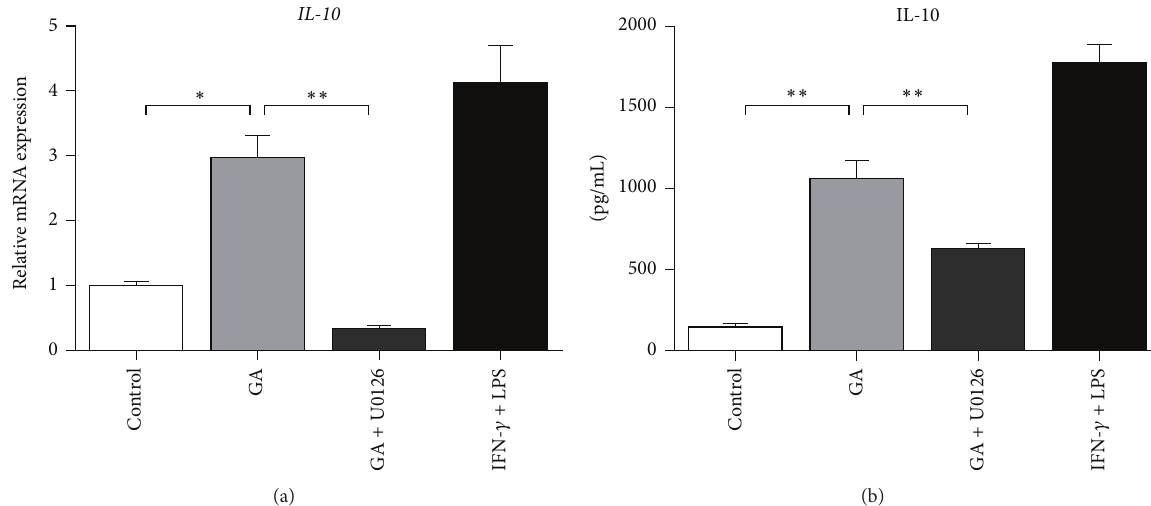
Figure 8: Effect of ERK1/2 pathway on GA-induced IL-10 production in M1-polarized BMDMs. BMDMs were pretreated with ERK1/2 inhibitor (U0126, 10 𝜇 M) followed by treatment with GA (100 𝜇 g/mL) for (a) 6 h or (b) 48 h, and IL-10 mRNA expression and IL-10 secretion were measured by real-time PCR and ELISA, respectively. Data are mean ± SD for three independent experiments. ∗ 𝑃 < 0.05 , ∗∗ 𝑃 < 0.01 ( 𝑡